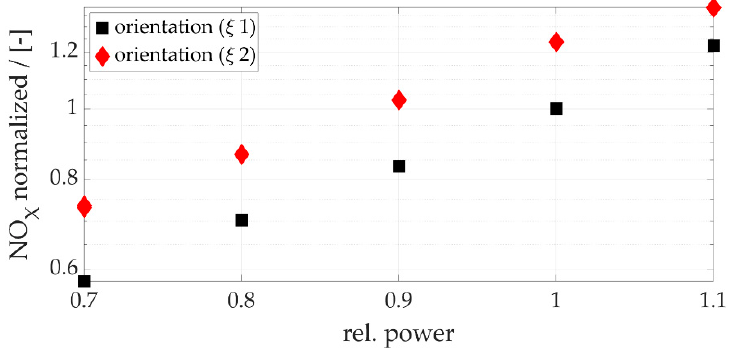
Figure 17. Normalized NOx emissions with respect to the relative engine power obtained at the high-pressure test rig; two variants ξ 1 and ξ 2 of liquid-fuel main nozzle orientations as introduced in Figure 10; NOx emissions normalized with baseload value of burner variant with orientation ξ 1.